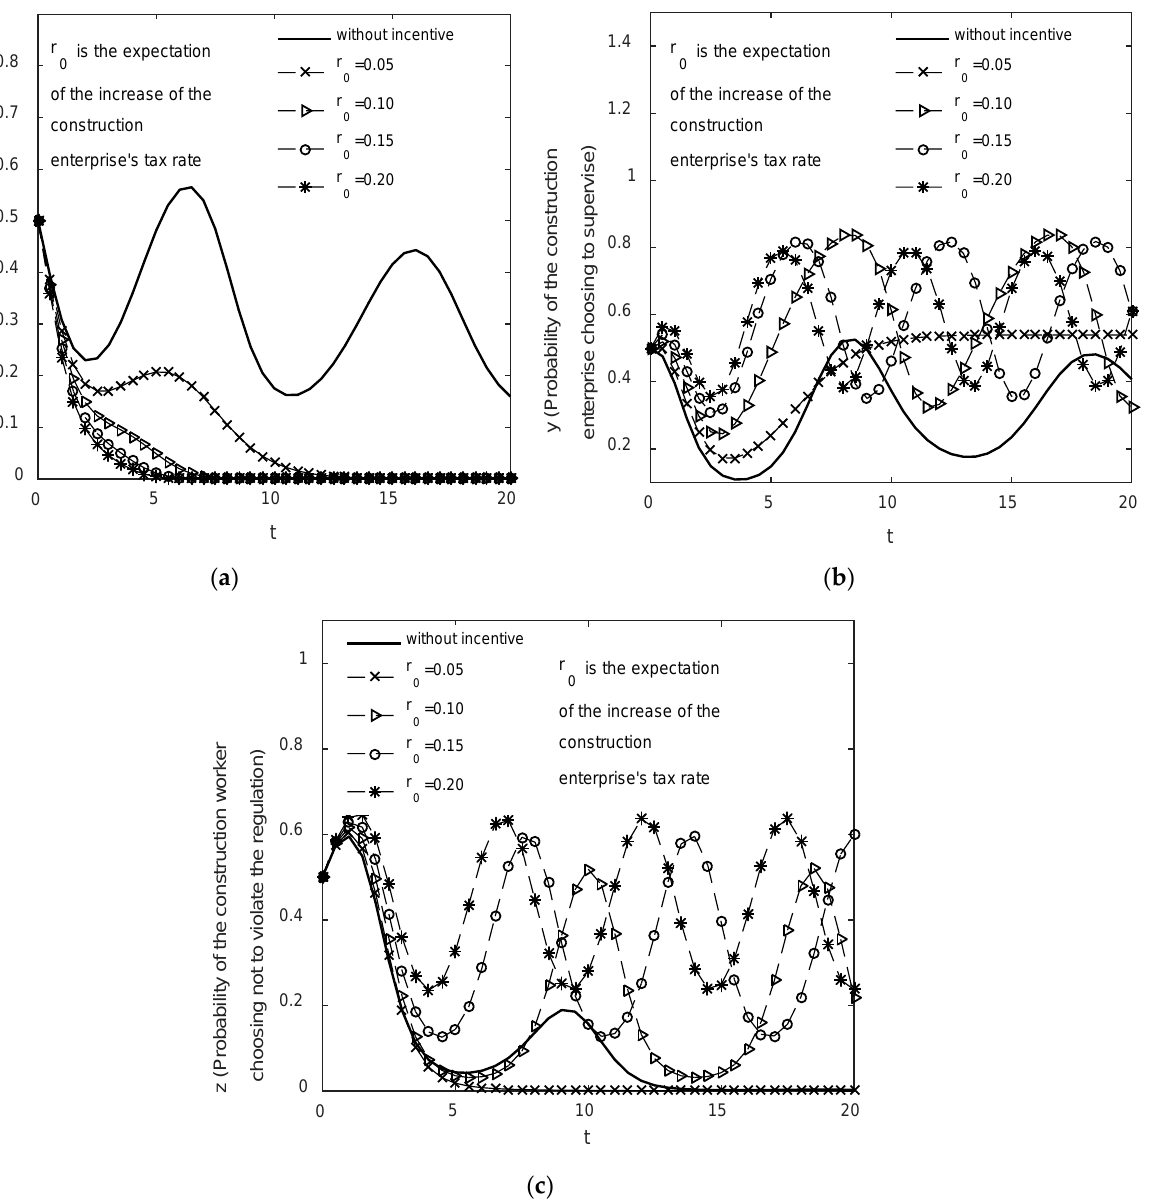
Figure 8. The impact of the tax mechanism that encourages the construction enterprise to supervise on the behavior evolution process: ( a ) the behavior evolution process of the local government under different tax incentive mechanisms; ( b ) the behavior evolution process of the construction enterprise under different tax incentive mechanisms; ( c ) the behavior evolution process of the construction worker under different tax incentive mechanisms.